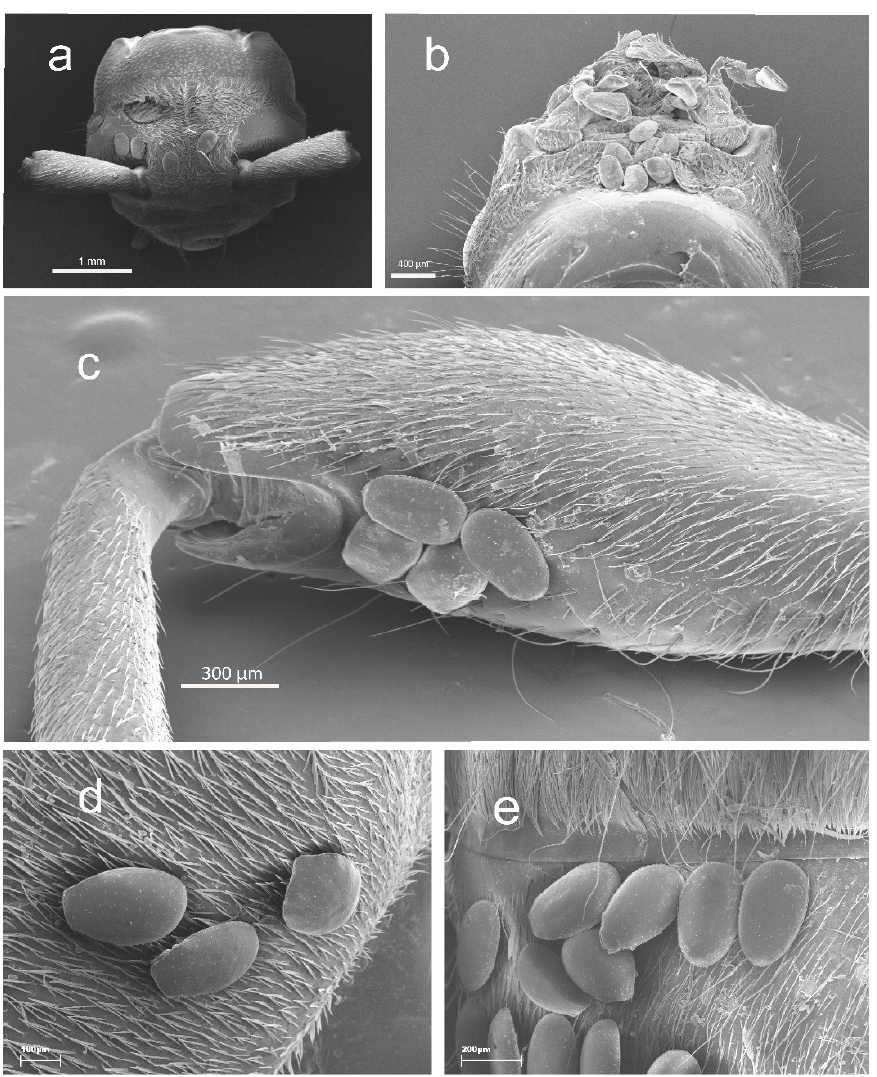
Figure 1. Deutonymphs of Trichouropoda sociata attached to Plagionotus detritus : ( a ) dorsal side of the head; ( b ) below the mouthparts; ( c ) foreleg; ( d ) dorsal surface of the elytra; ( e ) abdominal ventrites.